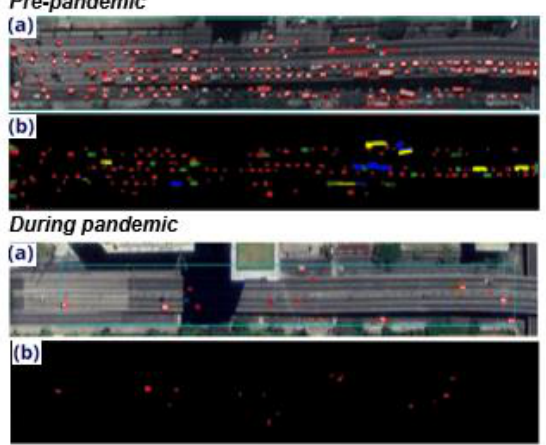
Figure 5. Vehicles in Eastwood delineated in (a) Google Earth